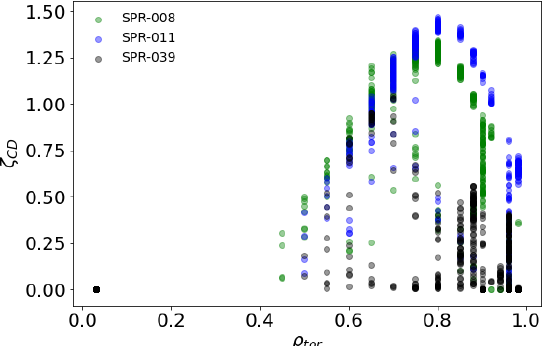
Fig. 6 : normalised current drive efficiencies for the three different plasma